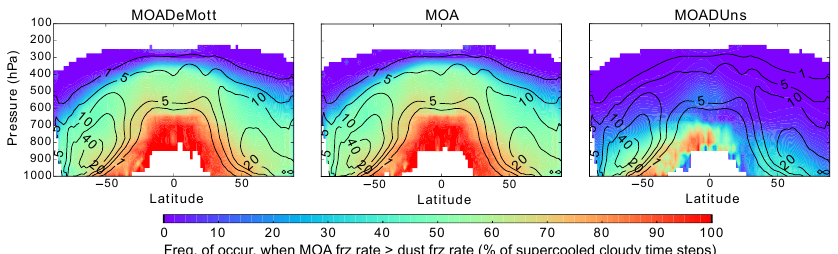
Figure 8. The annually and zonally averaged frequency of occurrence when the freezing contribution from MOA is greater than that from dust aerosol, diagnosed only for cloudy grid boxes containing supercooled droplets. Contour lines denote the frequency of occurrence (in %) of the above-mentioned favourable cloudy condition containing liquid droplets in the mixed-phase temperature range. All plots are from the respectively titled 10-year free-running simulations.